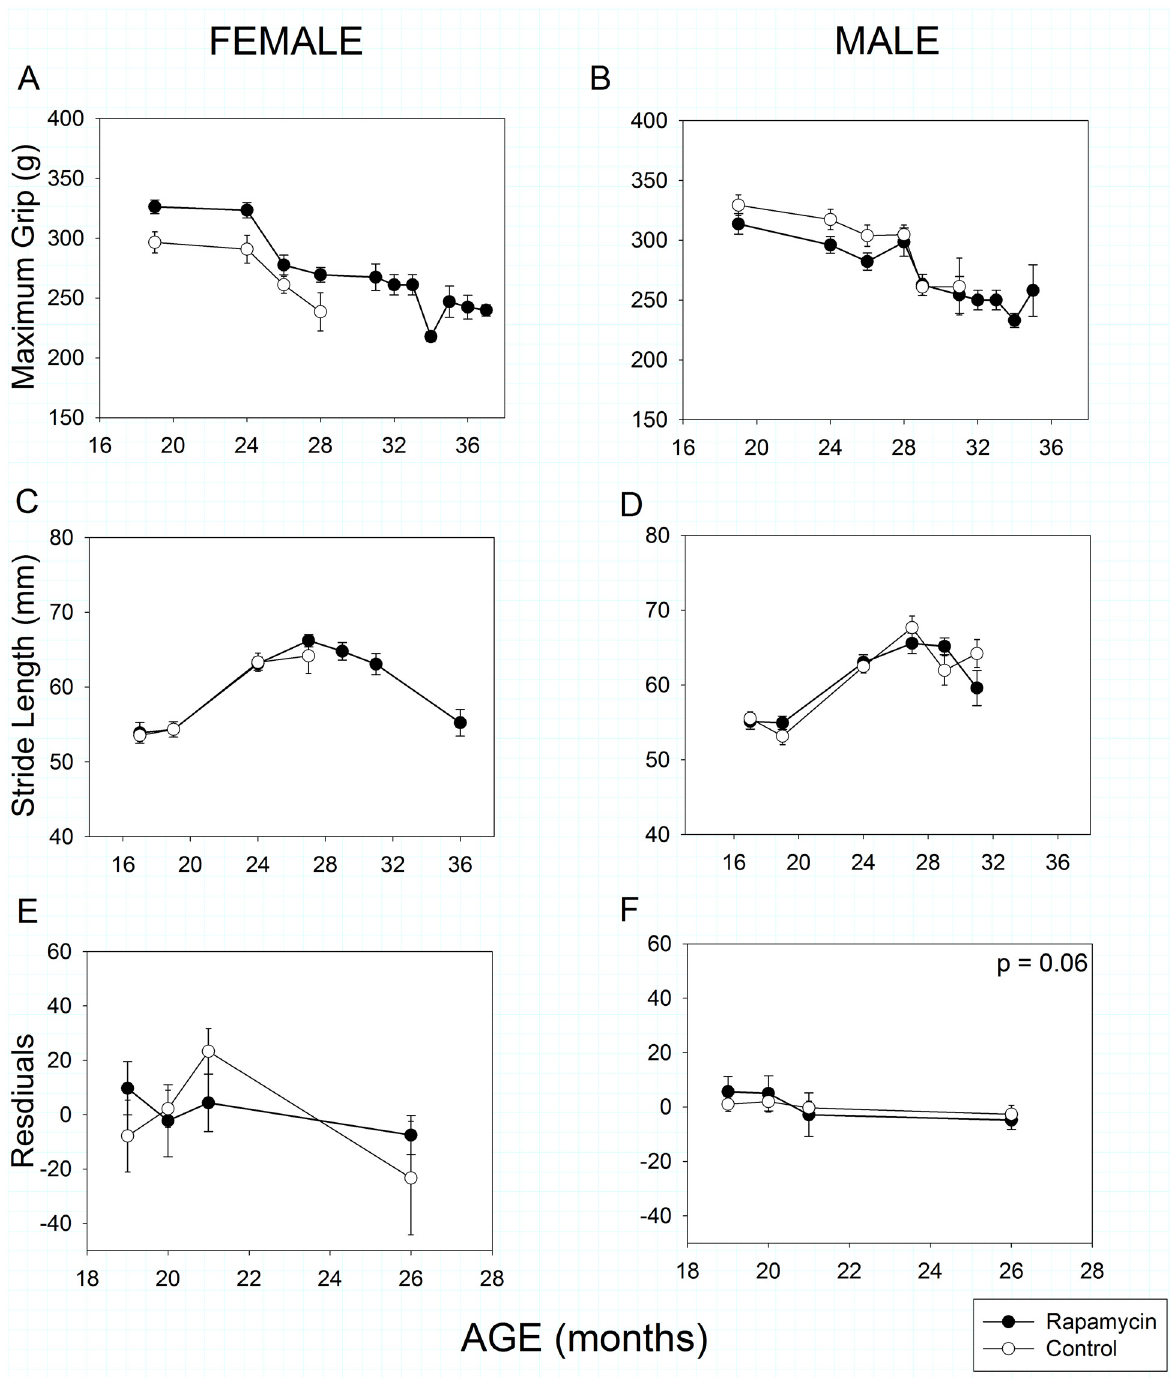
Fig 5. Strength, coordination and movement in rapamycin-fed mice (filled circles) compared to controls (hollow circles). P-values shown on individual panels only if there is a significant treatment effect independent of age. A, B: Grip strength declined significantly with age in all animals, regardless of treatment (p << 0.001); however rapamycin treatment affected males and females differently (treatment x sex, p = 0.003). Rapamycin-fed females had greater grip strength than controls at all ages measured; whereas grip strength in control and rapamycin treated males did not differ. Sample sizes varied, depending on age, control females, n = 17 – 7; rapamycin females, n = 27 – 4; control males, n = 22 – 4; rapamycin males, n = 31 – 3. C, D: Stride length increased in males and females until 27 months of age and then declined with increasing age (p << 0.001). Rapamycin treatment had no effect on stride length in either sex. Sample sizes varied, depending on age, control females, n = 15 – 6; rapamycin females, n = 21 – 5; control males, n = 19 – 4; rapamycin males, n = 26 – 9. E, F: Rotarod performance , measured as maximum latency to fall, was significantly affected by body mass (p << 0.001) and so body